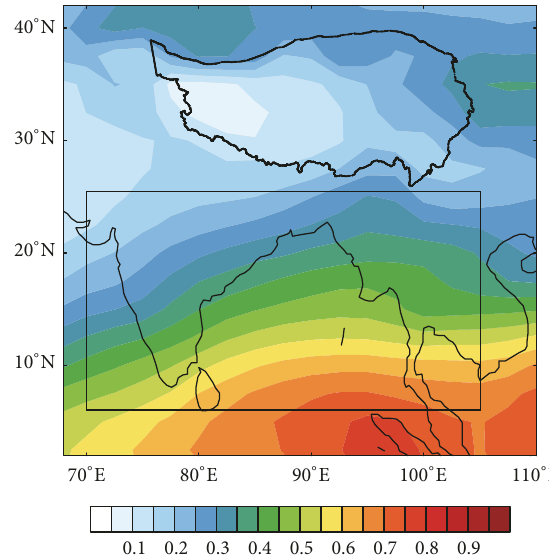
Figure 5: The spatial distribution of total cloud over TP and IMR.